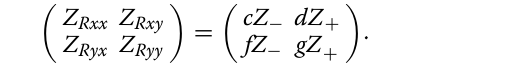
Algorithm 3 A third algorithm that still relies on the GB model but does not require fitting the measured data can be implemented as follows. Consider the original GB decomposition and multiply on the left-hand side by R and on the right by . The result is: